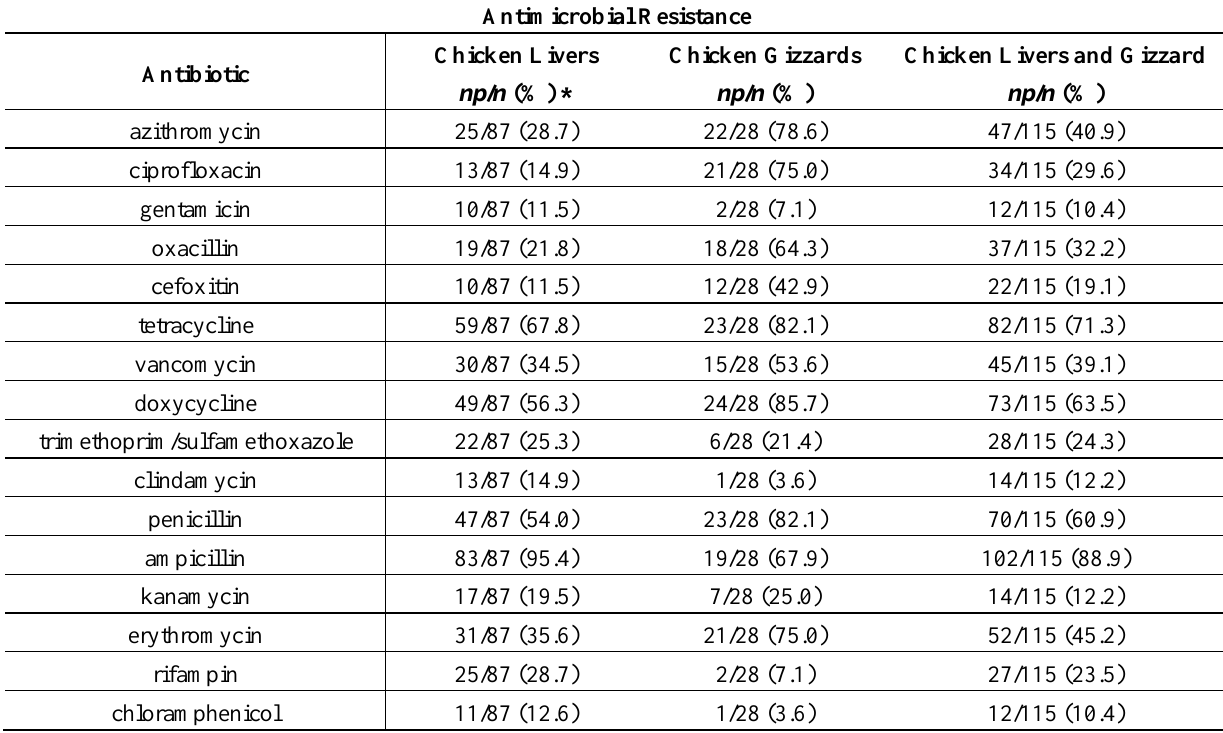
Table 5. Antimicrobial resistance of the 115 Staphylococcus aureus chicken liver and gizzard isolates against 16 different